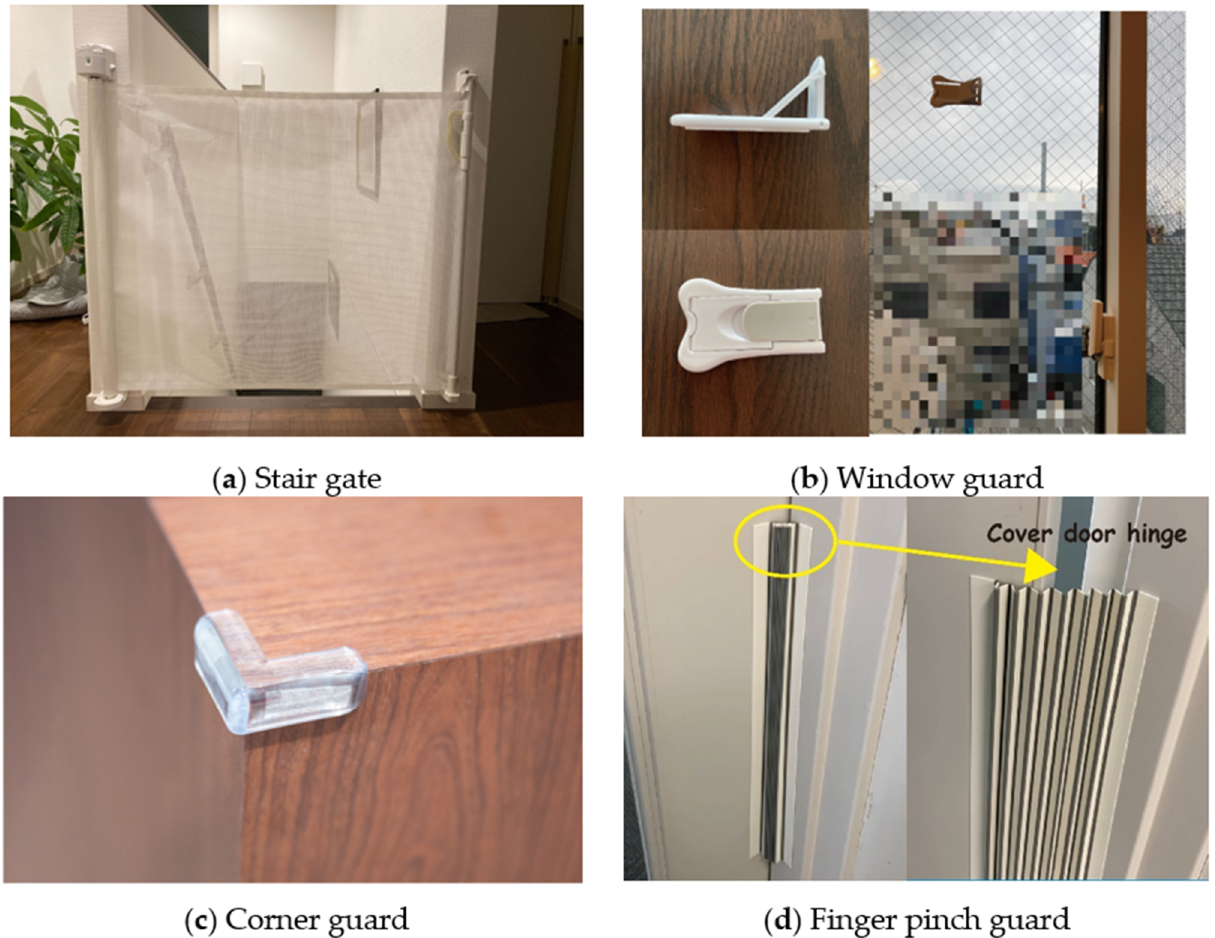
Figure 1. Examples of safety goods: ( a ) Stair gate at the top of the stairs. Stair gates need to be used at both the top and bottom of the stairs; ( b ) Window guard. Window guards limit the distance a window can be opened; ( c ) Corner guard; ( d ) Finger pinch guard.